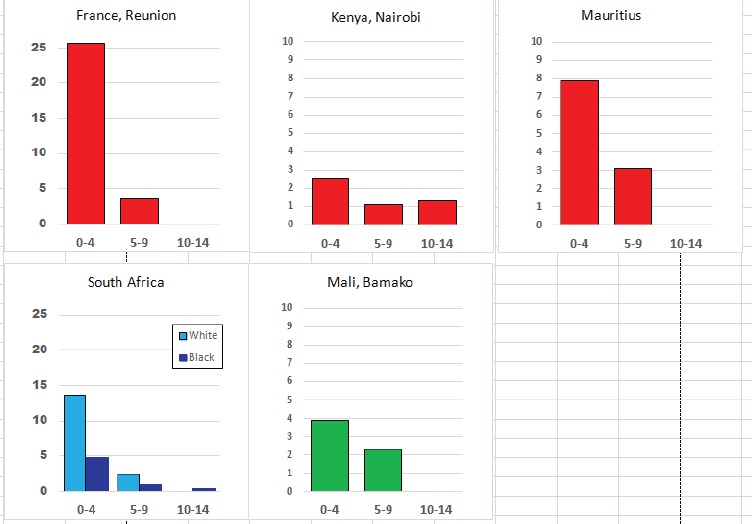
Age-specific histograms – neuroblastoma.